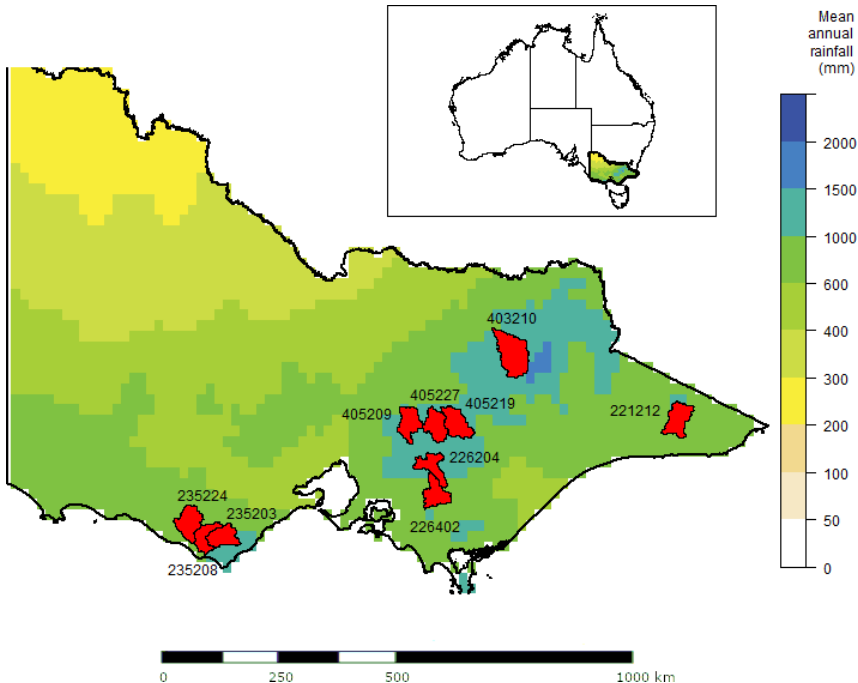
Figure 1. State of Victoria, Australia, mean annual rainfall for AWAP for 1990–2009 and location of study catchments used for rainfall– runoff